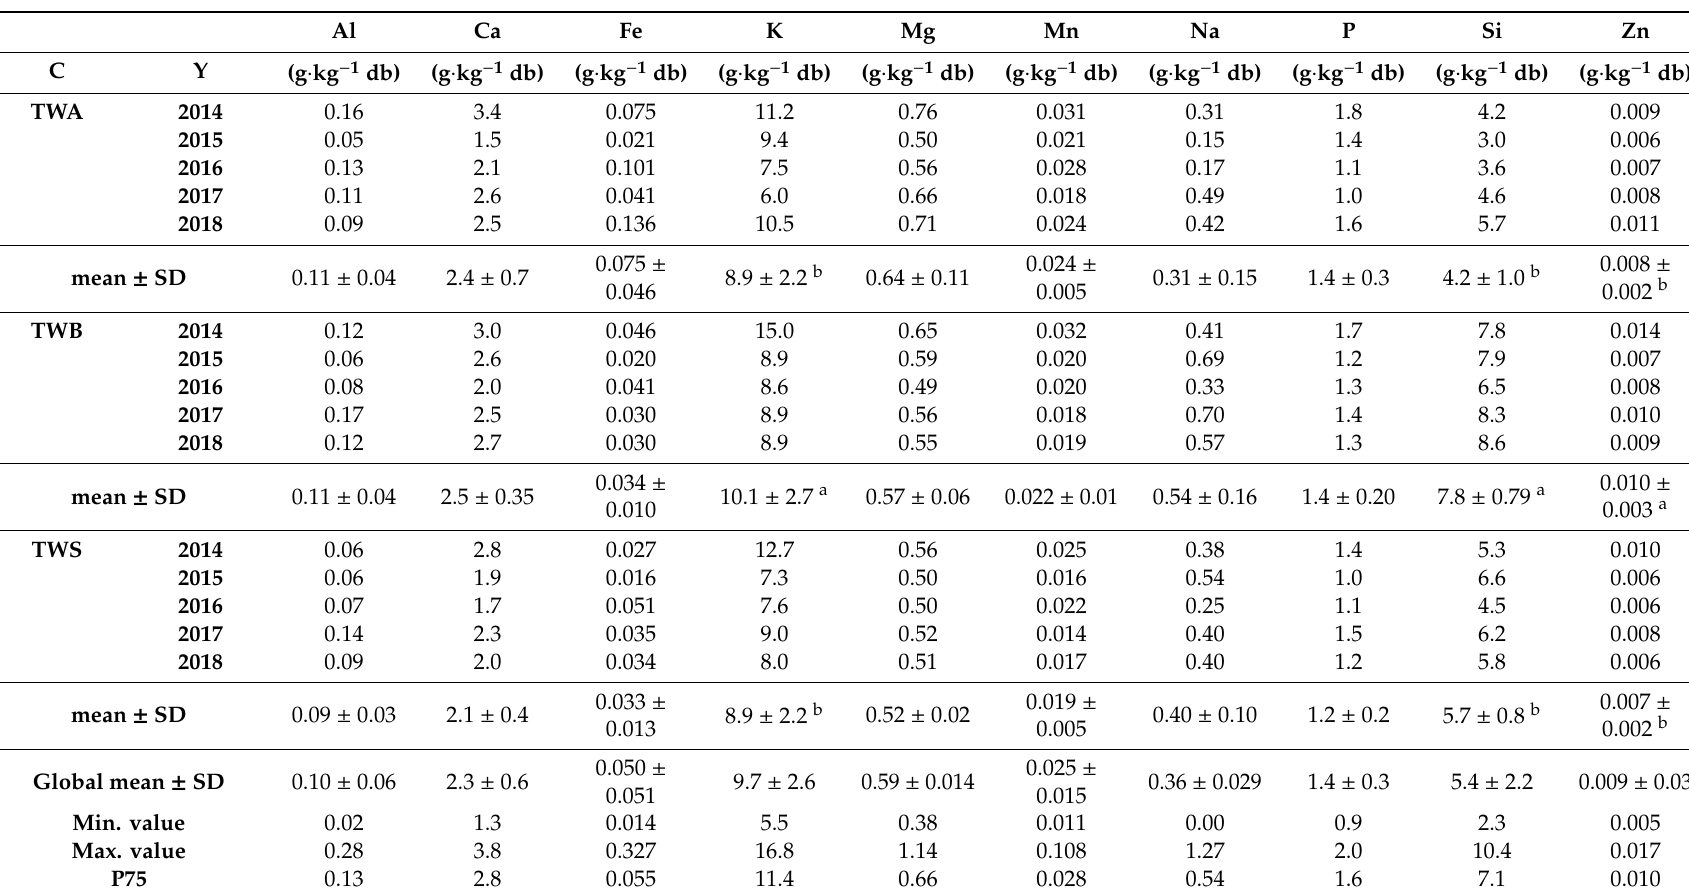
Table 9. Major elements present in the biomass of the tall wheatgrass cultivars collected at AL plots from 2014-2018. Mean values for three replicate plots per cultivar and